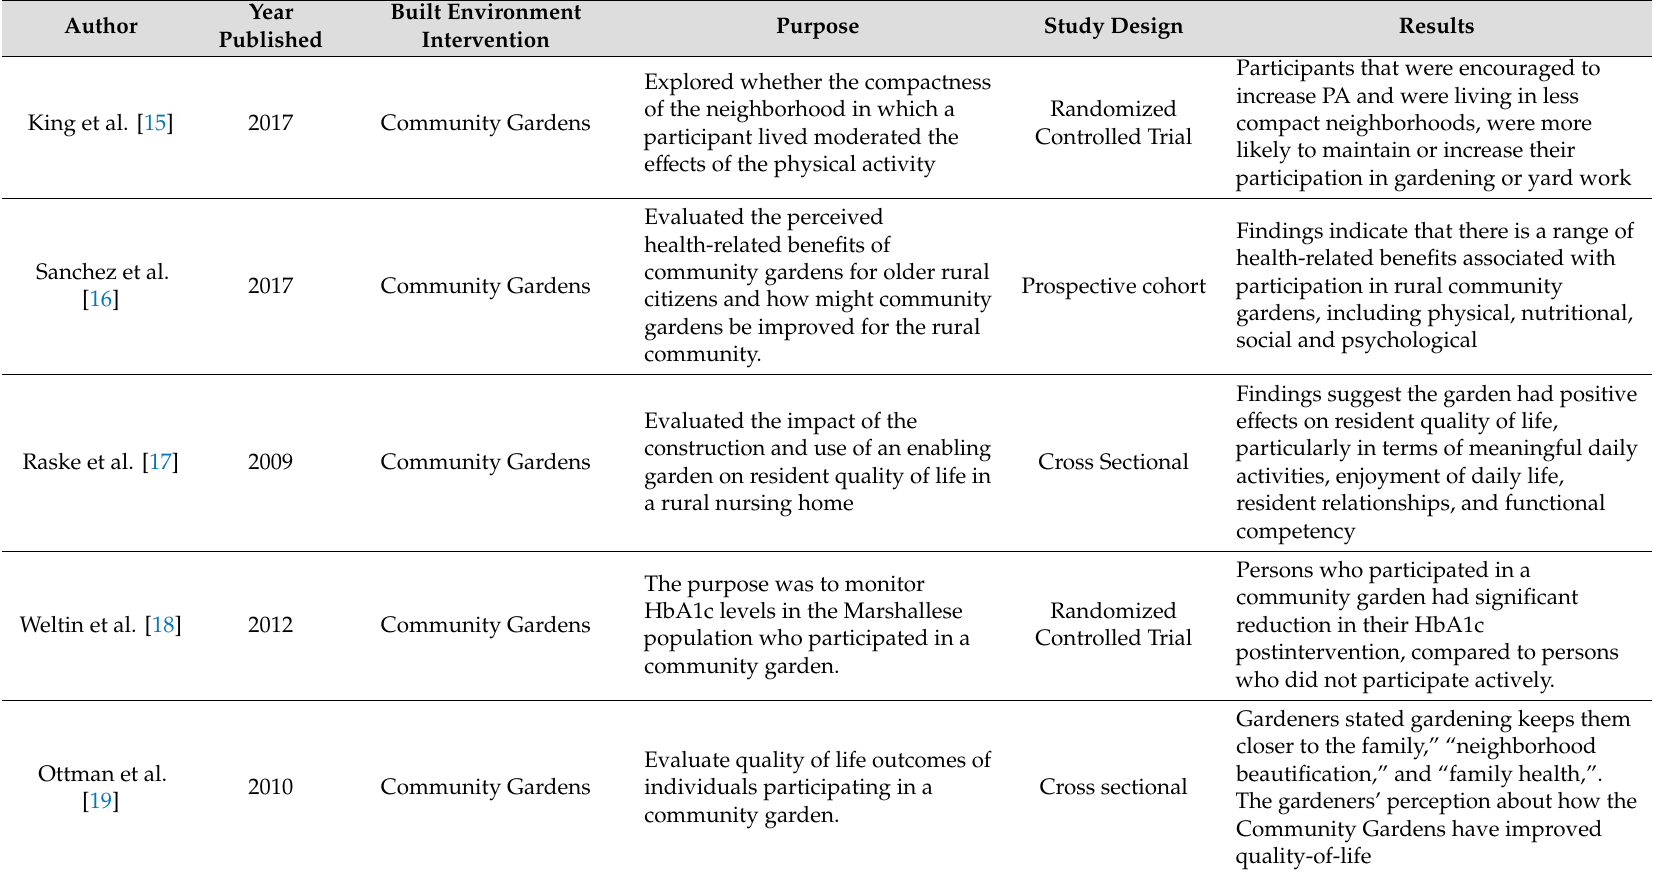
Table 1. Included